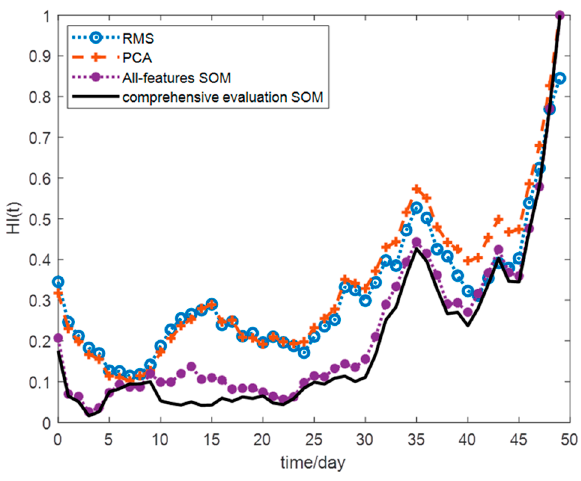
Figure 8. Bearing HI curves constructed using different methods.